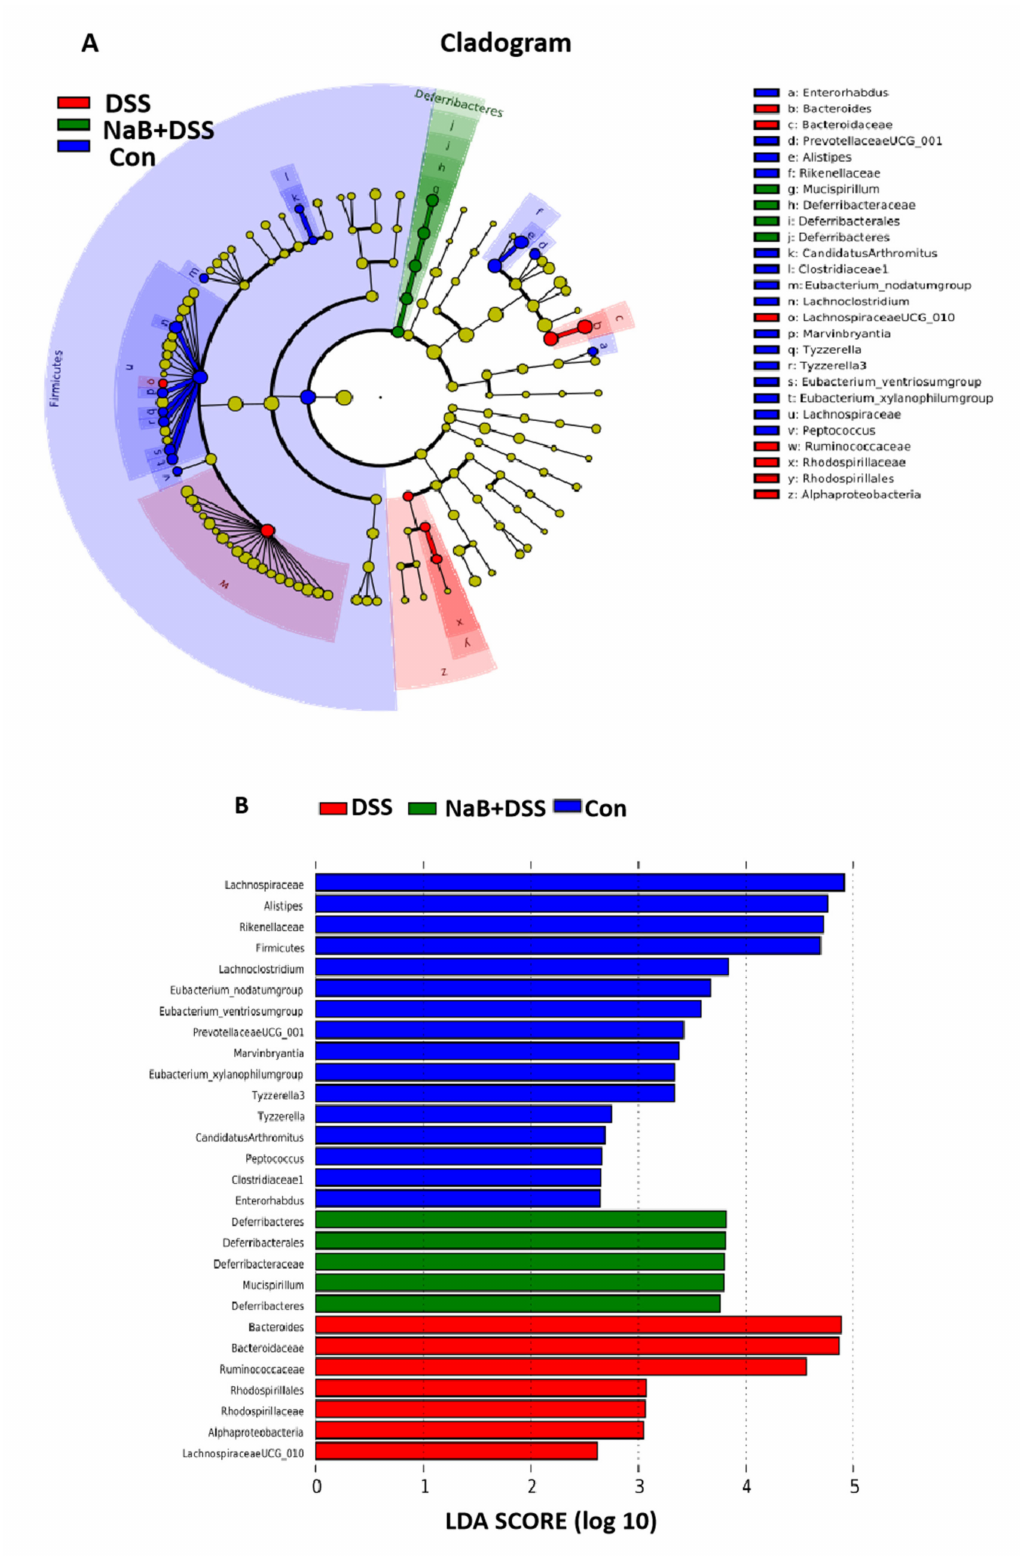
Figure 3. LEfSe analysis of the microbiota: ( A ) taxonomic cladogram generated from the LEfSe analysis of 16S rRNA sequences and ( B ) bacterial taxa that met the criterion of an LDA score > 2 and were considered biomarker